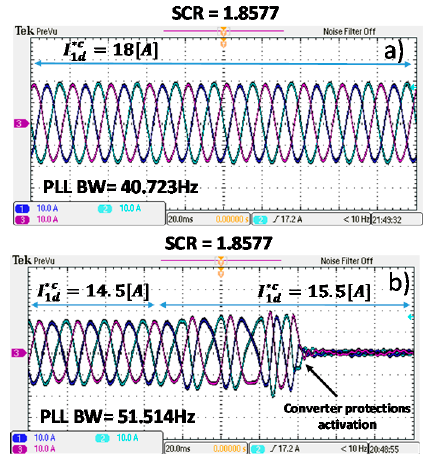
Figure 11. Experimental results: ( a ) Maximum active current injected by the converter into the grid with a PLL bandwidth of 40.723 Hz (10 A/div); ( b ) Maximum active current injected with a PLL bandwidth of 51.514 Hz (10 A/div).